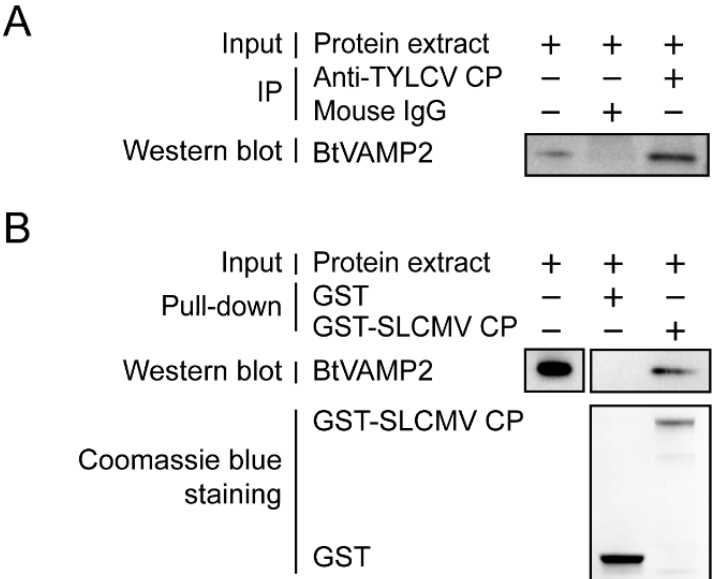
Figure 5. Interaction analysis between Asia II 1 BtVAMP2 and SLCMV CP. ( A ) Co-IP analysis. The cytoplasmic proteins of Asia II 1 whitefly fed on SLCMV-infected plants for 7 d were extracted and incubated with either anti-TYLCV CP mAb and protein G-Sepharose beads, or mouse IgG and protein G-Sepharose beads as a negative control. After Co-IP, anti-BtVAMP2 rabbit pAb was used to detect BtVAMP2 by Western blot. ( B ) GST pull-down analysis. GST-SLCMV CP or GST was used as bait protein, and the native cytoplasmic proteins of Asia II 1 whitefly were used as prey protein. Anti-BtVAMP2 rabbit pAb was used to detect whether BtVAMP2 protein was pulled down.